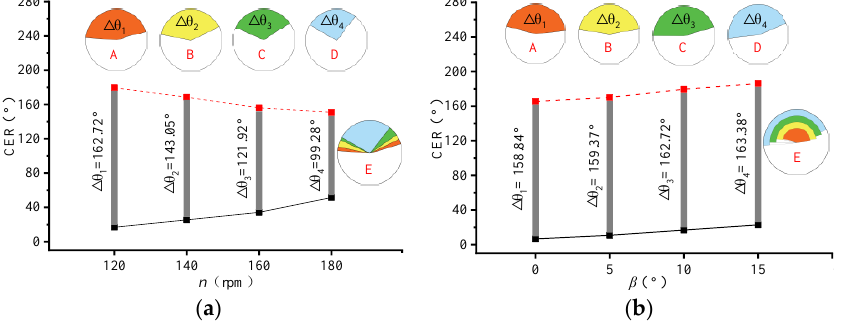
Figure 12. CER variations with n and β . ( a ) Drill pipe rotary speed; ( b ) sieve hole inclination angle.